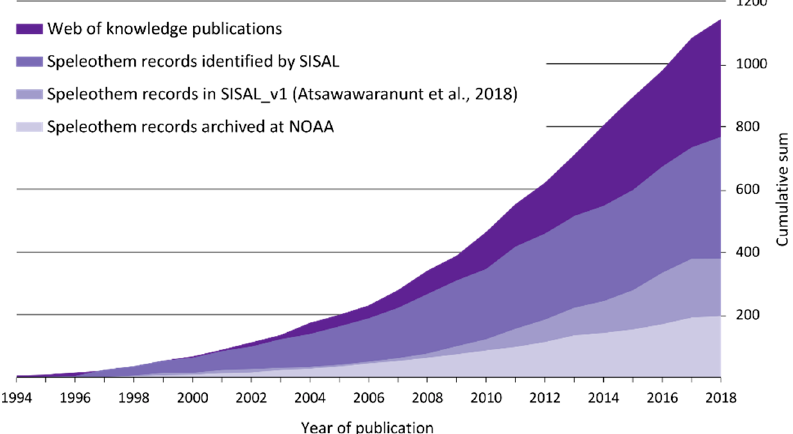
Figure 1: Evolution of speleothem palaeoclimate research. Data from top to bottom: “Web of Knowledge” are the publications that resulted from querying the keywords “speleothem” and “isotope” in http://www.webofknowledge.com on 10 June, 2018 (may include publications only using the records). Speleothem records identified by SISAL working group members. Records in the SISAL database [16,17]. Speleothem records lodged in the NOAA repository as of 5 October 2108 (https://www.ncdc.noaa.gov/data-access/paleoclimatology-data). Compilations have been excluded. SISAL (Speleothem Isotopes Synthesis and Analysis,